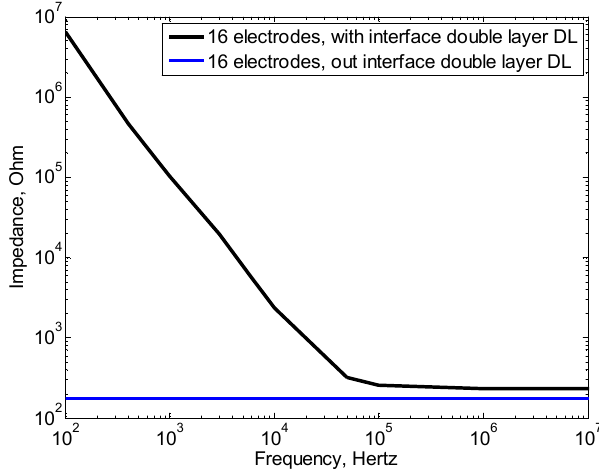
Fig.9 : Simulated electrical impedance for a full blood medium deposited on the interdigitated structure of 16 electrodes. The medium is modeled with and without interface double layer DL.